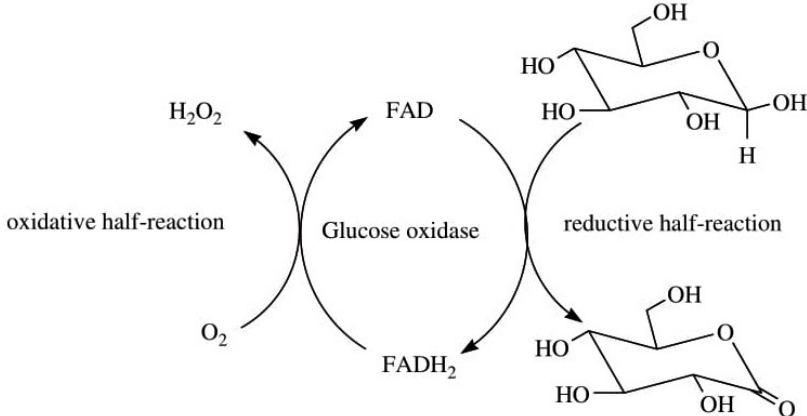
Figure 5. Schematic diagram for the oxidation of β -D-glucose, as catalysed by glucose oxidase (Source: Adányi et al. [85]).